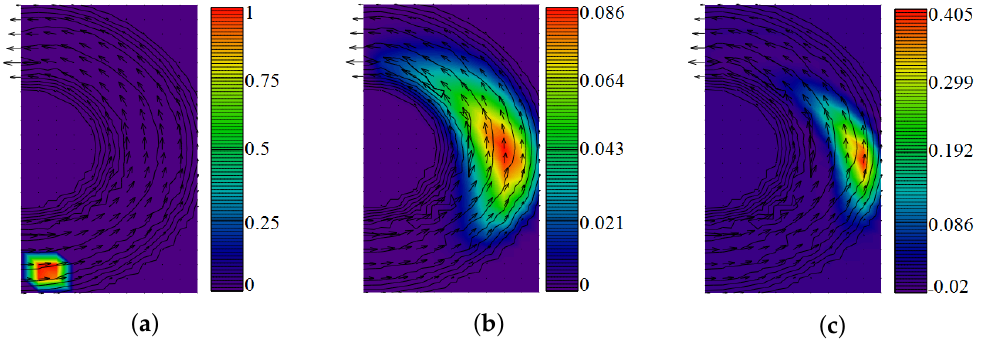
Figure 5. Numerical solution of the problem of the transfer of substances between two coaxial cylinders at large grid Péclet numbers: ( a ) the initial distribution of the concentration field; ( b ) and ( c ) the result of calculating the concentration field based on the difference scheme (15) and (19)–(22),